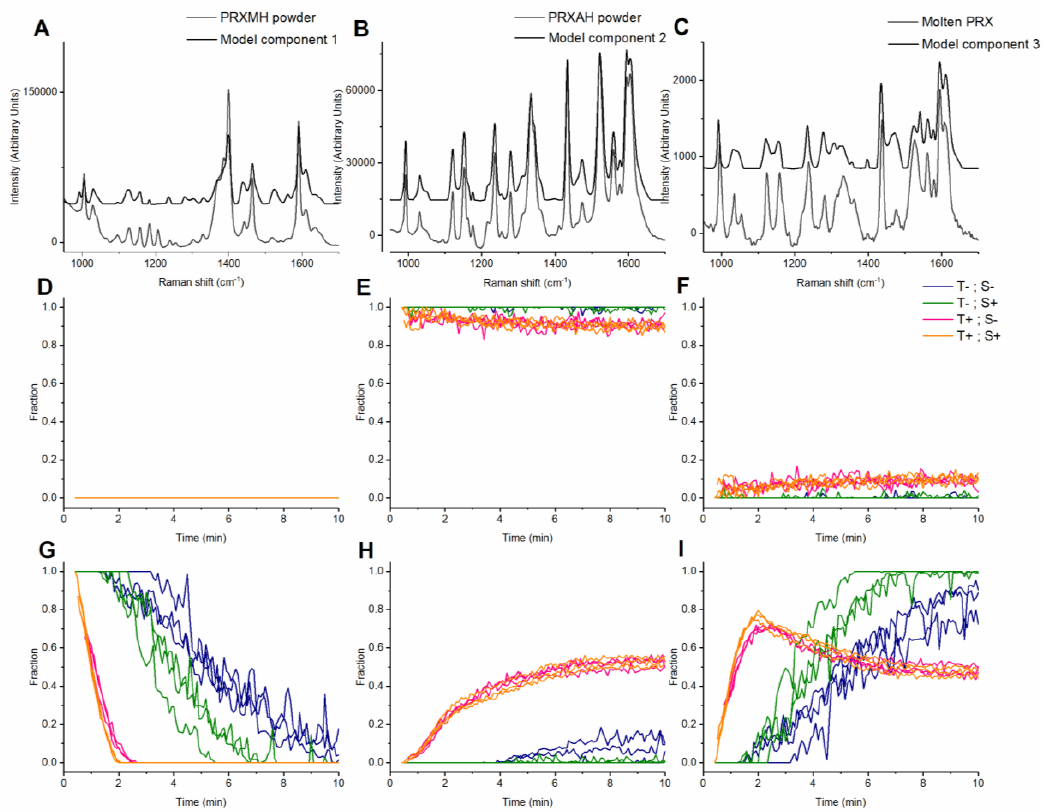
Figure 4. Loadings and score values (relative fraction) of a 3-component MCR model of the piroxicam (PRX) dataset collected during extrusion at different process conditions, ( A ), ( B ) and ( C ) Loadings of component 1,2 and 3 (black) against PRXMH powder, PRXAH powder and molten PRX (gray), respectively; ( D ) score values of PRXAH-PEO samples on component 1, ( E ) score values of PRXAH-PEO samples on component 2. ( F ) score values of PRXAH-PEO samples on component 3, ( G ) score values of PRXMH-PEO samples on component 1, ( H ) score values of PRXMH-PEO samples on component 2 and ( I ) score values of PRXMH-PEO samples on component 3. Process conditions indicated with colors T–: 70 °C, T+: 90 °C, S–: 25 rpm and S+: 50 rpm.